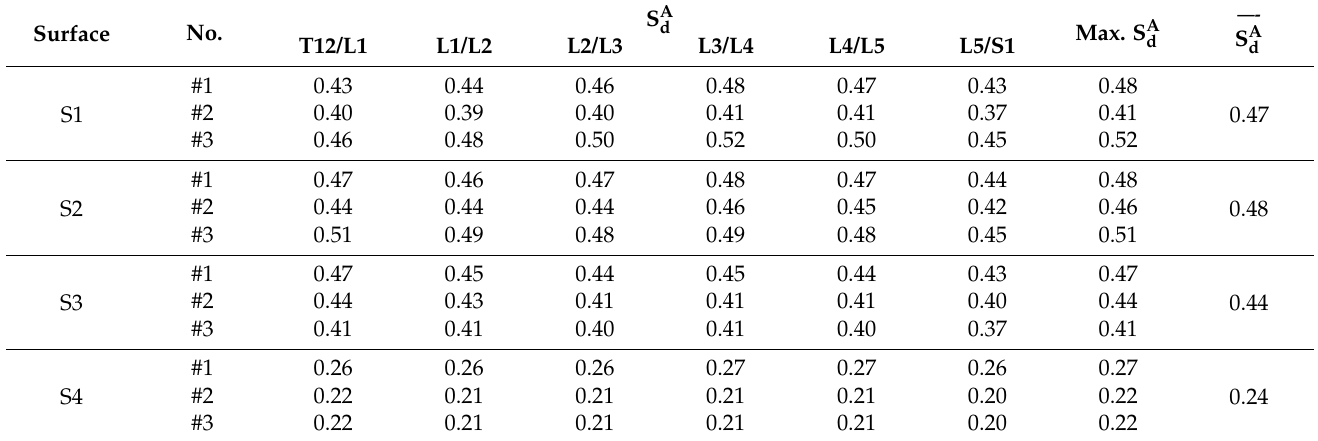
Table 8. Summary of data obtained from driver 1 according to ISO 2631-5:2018, less severe method. Surface